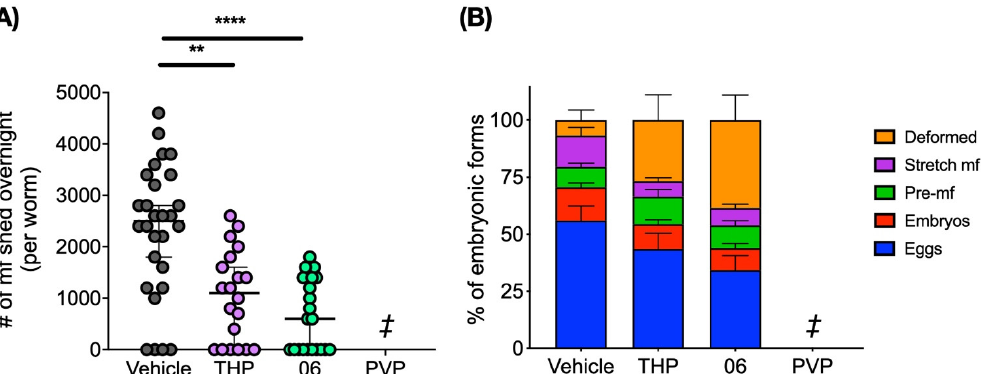
Figure 4. THP and 06 reduce fecundity in female worms recovered from animals treated intraperi- toneally with 1 mg/kg. ( A ) Mf released overnight from females recovered from animals treated IP with 1 mg/kg THP and 06 was significantly reduced (**, p < 0.01 and ****, p < 0.0001, respectively). ( B ) THP and 06 impaired embryogenesis: a minimum of 200 embryonic forms within the ovaries and uteri from female worms were counted and scored based on their developmental stages (eggs, embryos, pre-mf, stretched mf and deformed embryos). There was a statistically significant increase in the number of deformed embryos in the THP group ( p < 0.05) and 06 group ( p < 0.001) compared to the vehicle group (Supporting Information Table S2). Data are presented as the mean ± SEM. ‡ Only one female worm was recovered from all the animals treated with 1 mg/kg PVP; therefore, no analyses of overnight mf shed nor embryograms were conducted.